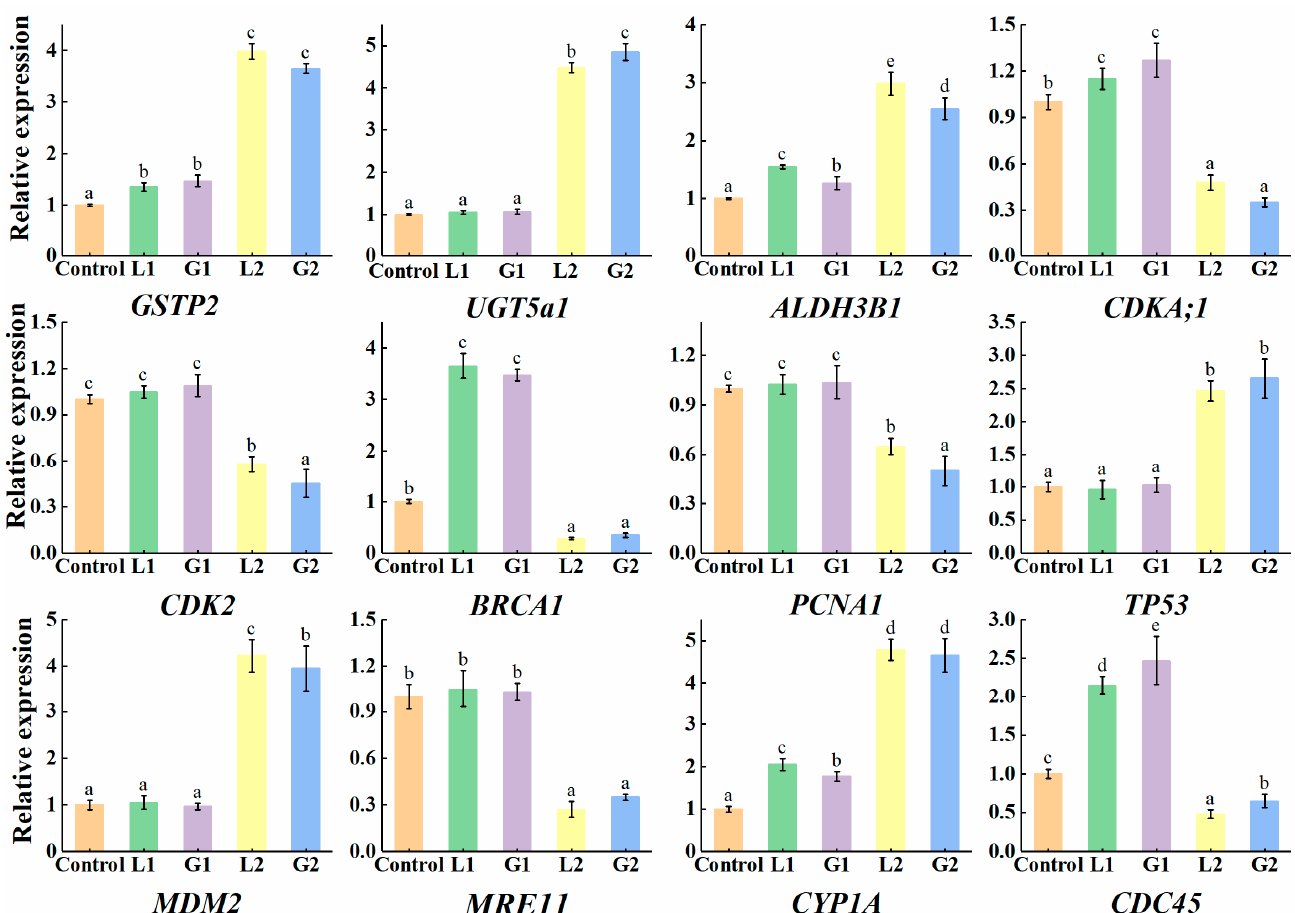
Figure 4. Differential expression in liver tissues of Danio rerio exposed to La and Gd: L1, 15 µ mol L − 1 La; L2, 30 µ mol L − 1 La; G1, 15 µ mol L − 1 Gd; and G2, 30 µ mol L − 1 Gd. Data are shown as mean ± SD by qPCR. The expression of the control was set as 1. Data presented are the average of three replicates. Housekeeping gene ACT2 was used as an internal control, the same below. Different letters indicate significant differences in gene